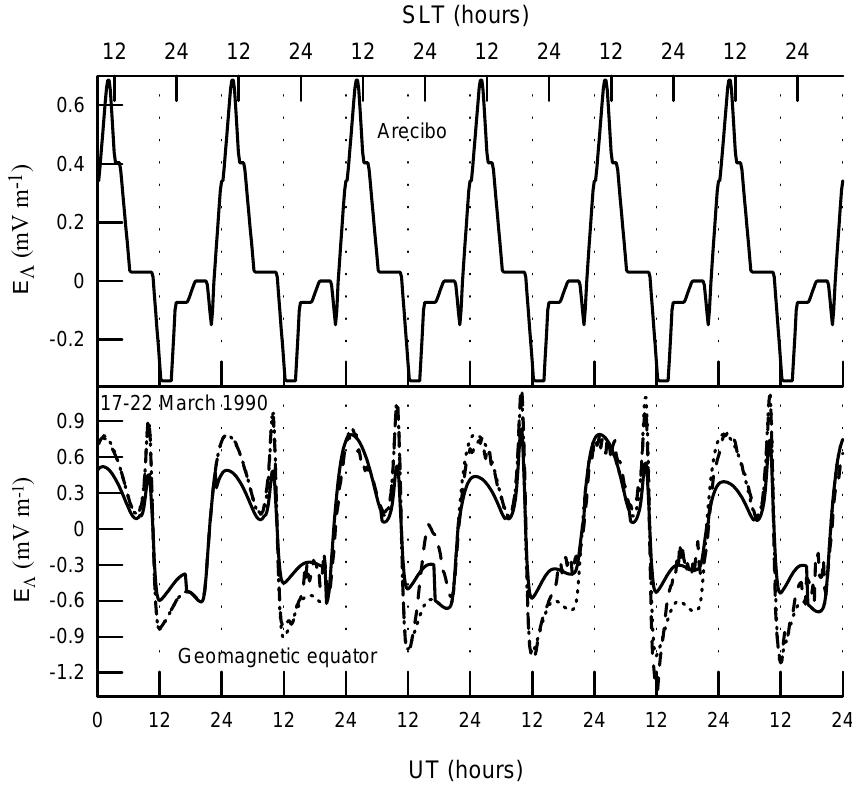
Fig. 2. Diurnal variations of the F-region zonal electric field during 17-21 March 1990 over the geomagnetic equator at 201.45 ◦ geomagnetic longitude (bottom panel) and over Arecibo (top panel). The zonal electric field at the F-region altitudes over Arecibo is found from Fig. 2 of Fejer (1993).The dashed line in the bottom panel show the storm-time equatorial zonal electric field found from the empirical model of Fejer and Scherliess (1997), while the geomagnetically quiet equatorial zonal electric field found from the empirical model of Scherliess and Fejer (1999) is presented by the dotted line in the bottom panel. The quiet equatorial zonal electric field is modified by the use of the comparison between the measured and modeled values of hm F2 and Nm F2 over the Manila, Vanimo, and Okinawa sounders (see Sect. 4.1) to produce the resulting storm-time equatorial zonal electric field shown by the solid line in the bottom panel. SLT is the local solar time at the geomagnetic equator and 201.45 ◦ geomagnetic longitude on the surface of the